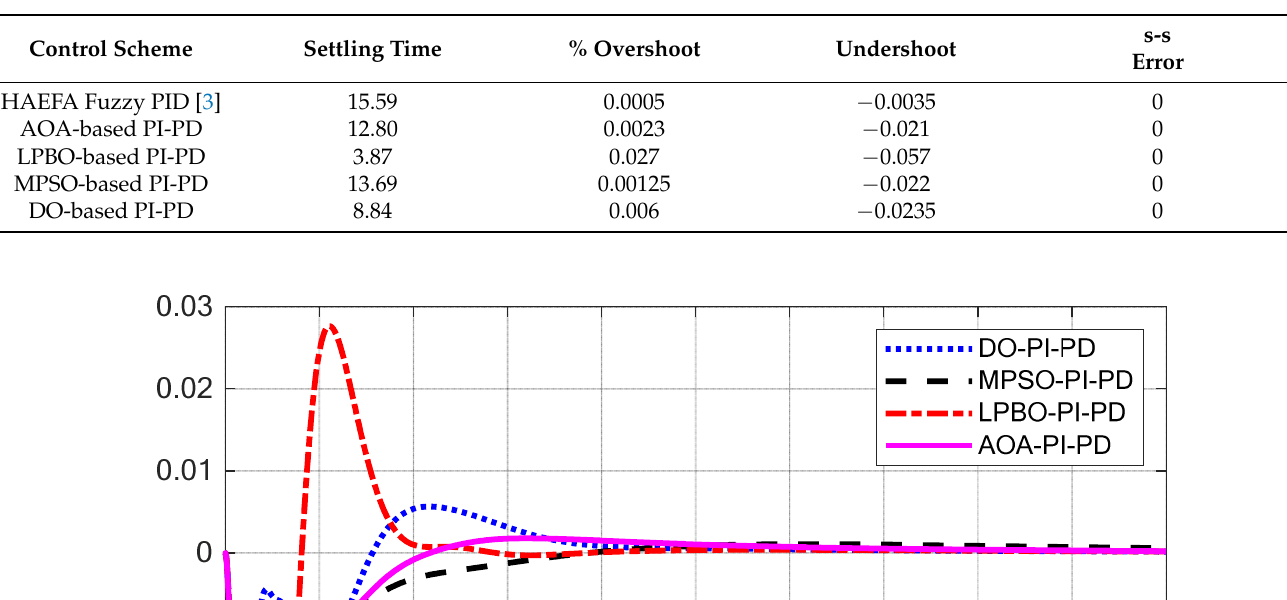
Table 7. Numerical results of tie-line power deviation in a two-area multi-source IPS.